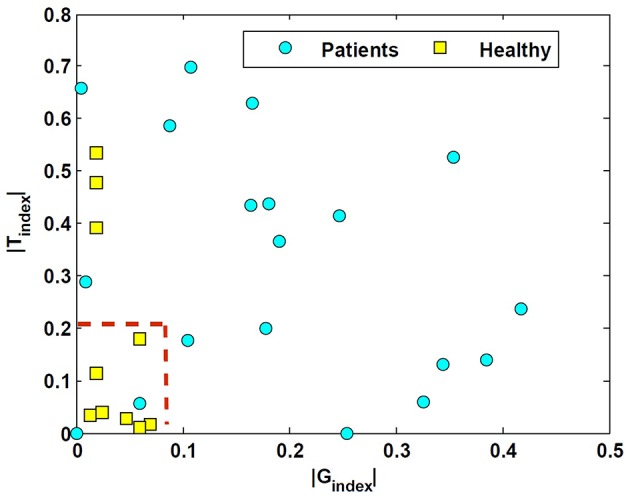
Tindex vs. Gindex in unilateral patients and normal subjects. These indices refer to the relative difference of the estimated rightward-leftward parameters and emphasize the extent of asymmetries in the estimated VOR dynamics between the control and patient group.